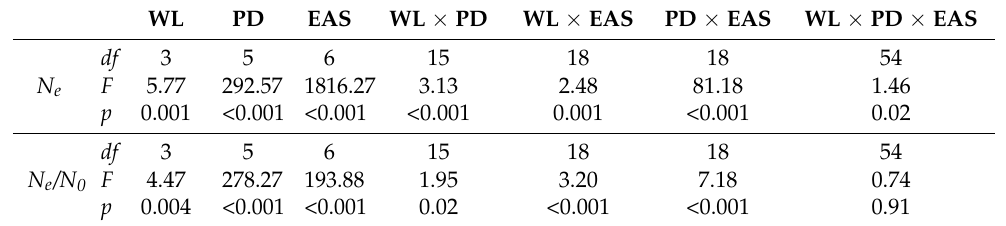
Table 2. Three-way (wheat line, prey densities, and ladybird age stage) ANOVA results of the prey consumed ( N e ) and proportion of prey consumed ( N e /N 0 ) of P. japonica . WL PD EAS WL × PD WL × EAS PD × EAS WL × PD × EAS df 3 5 6 15 18 18 54 F 5.77 292.57 1816.27 3.13 2.48 81.18 1.46 N e p 0.001 <0.001 <0.001 <0.001 0.001 <0.001 0.02 df 3 5 6 15 18 18 54 F 4.47 278.27 193.88 1.95 3.20 7.18 0.74 N e /N 0 p 0.004 <0.001 <0.001 0.02 <0.001 <0.001